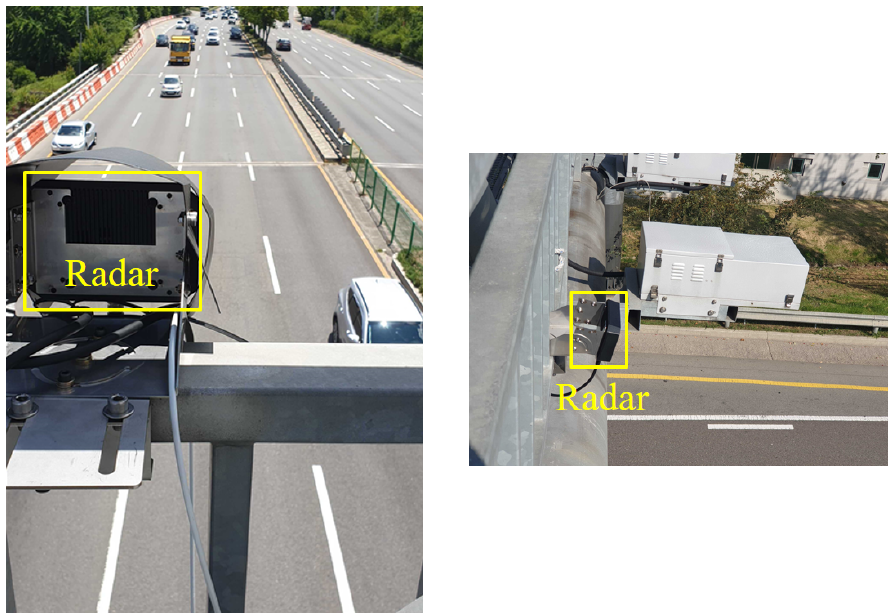
Figure 1. Traffic monitoring radar installed on the